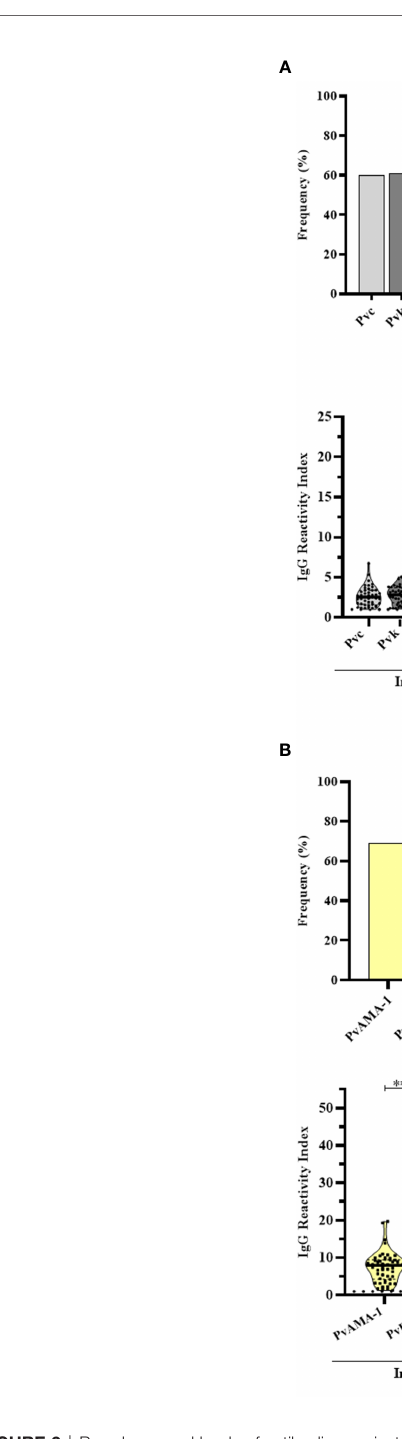
FIGURE 2 | Prevalence and levels of antibodies against Plasmodium antigens in neotropical primates. Frequency and reactivity index (RI) of IgG antibodies against (A) CSP peptides and (B) Plasmodium vivax erythrocytic antigens among NP from Indaial/SC, Joinville/SC, and Guapimirim/RJ. RI > 1 was considered positive (dotted line). The fi lled bars indicate the percentage of NP with RI > 1 ( A , B top). Data expressed as individual RI values (dots) and median with the interquartile range (boxes) ( A , B botton). Pvc: P. vivax CSP VK210 (light gray); Pvk: P. vivax CSP VK247 (gray); Pvl: CSP P. vivax -like (dark gray); Pb/Pm: P. brasilianum/P. malariae (blue); Pf: P. falciparum (green); PvAMA-1: P. vivax Apical membrane antigen – 1 (yellow); PvEBP-2: P. vivax Erythrocyte Binding Protein 2 (orange); PvDBPII: P. vivax Duffy Binding Protein region II (red). In the bottom of each graph is shown the numbers (n) of NP included in each area. Differences statistically signi fi cant were indicated by asterisk (* P < 0.05, ** P < 0.01, *** P < 0.001, **** P <